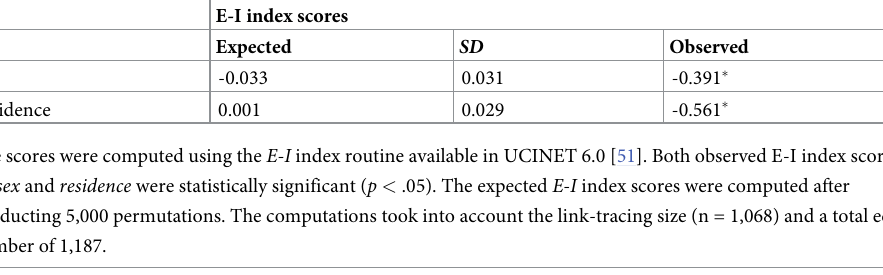
Table 5. Sex / place of residence E-I index scores computed in the link-tracing network.